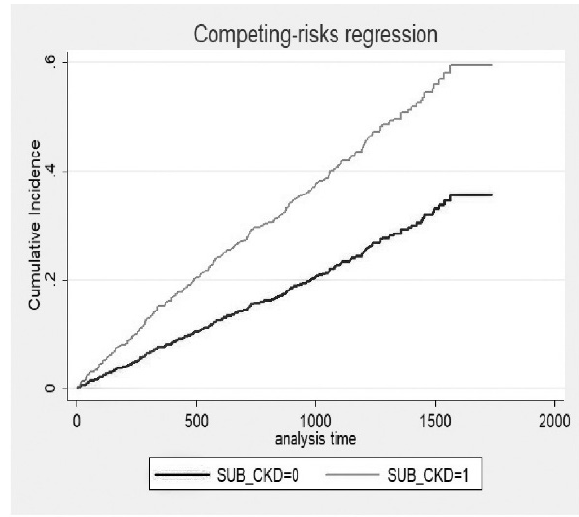
Figure 3. Cumulative Incidence Function Based on